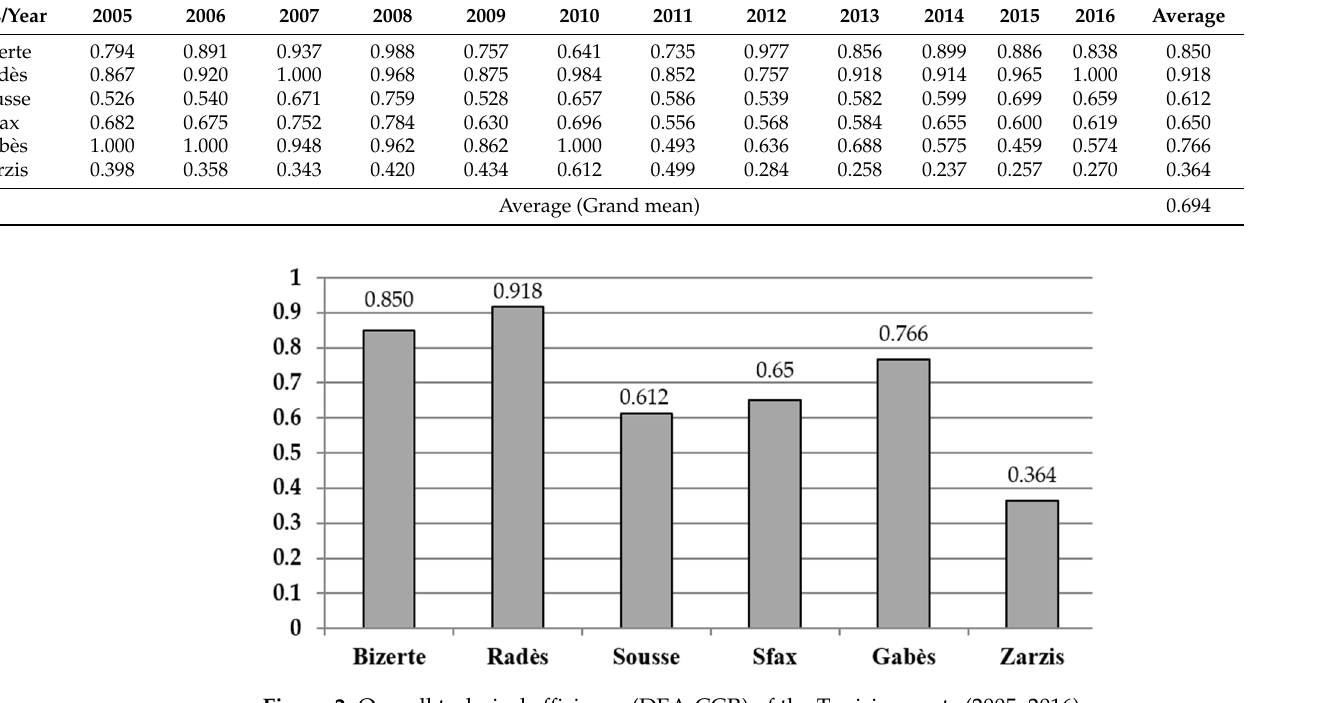
Figure 2. Overall technical efficiency (DEA-CCR) of the Tunisian ports (2005–2016).